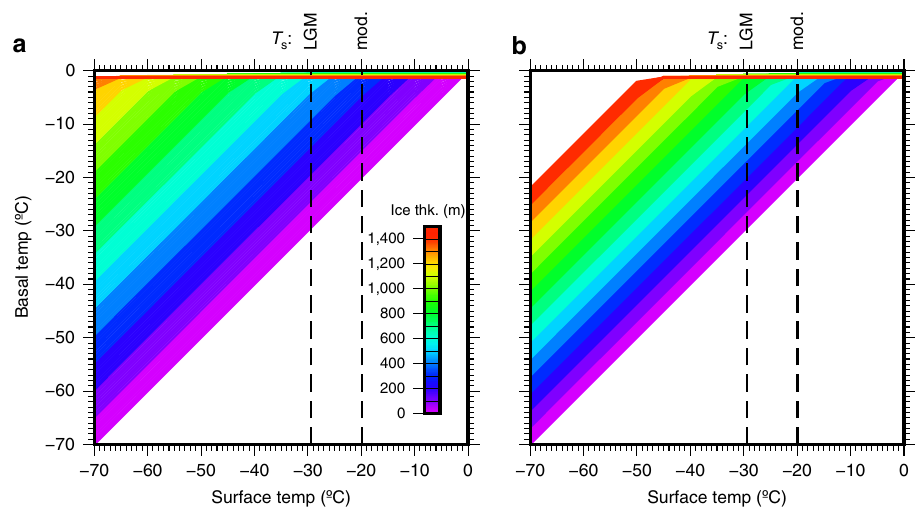
Figure 5 | Estimated LGM ice thickness at Boggs Valley. Modelled LGM ice thickness (equation (1)) necessary to induce basal melt for LGM temperature of 9.5 (cid:2) C lower than present 41 , and geothermal heat flux of ( a ) 120.9mWm (cid:2) 2 and ( b ) 75mWm (cid:2) 2